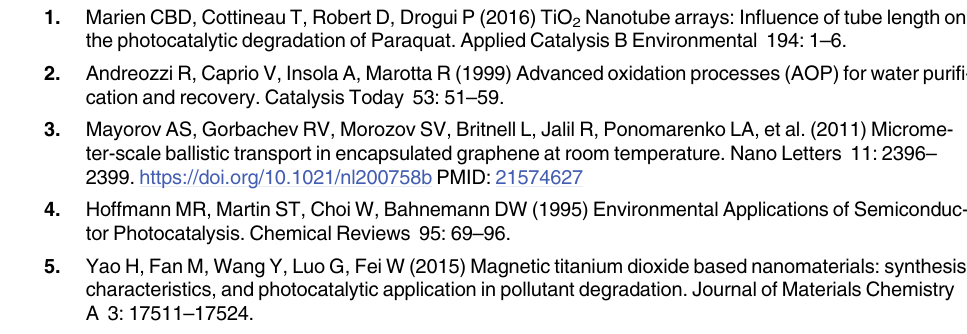
initial R6G concentration, 10 mg/L. Different small letters indicate significant difference (Duncan’s test, p < 0.05) among treatments (n = 3). S6 Fig. R6G declining curves of the synthesized magnetic-TiO -nanocomposites without 2 UV-irradiation. (A) pH = 3.0, (B) pH = 7.0, (C) pH = 10.0. Experimental conditions: initial magnetic-TiO2-nanocomposites concentration, 0.4 g/L; initial R6G concentration, 10 mg/L. Different small letters after each line indicate significant difference (Duncan’s test, p < 0.05) among treatments (n = 3). S7 Fig. Impacts of irradiation wavelength on the R6G photocatalytic degradation of the synthesized magnetic-TiO -nanocomposites. (A) 460 nm, (B) 540 nm. Different small letters 2 after each line indicate significant difference (Duncan’s test, p < 0.05) among treatments (n = 3). S8 Fig. Percentage of R6G loss during the photocatalysis process. The number in x-axis (0.2, 0.4 and 0.8) indicates the concentration of the synthesized magnetic-TiO -nanocompo- 2 sites (mg/L), A refers to Fe O /TiO -0.5, B refers to Fe O /TiO -0.35, C refers to Fe O @TiO - x y 2 x y 2 x y 2 0.5, and D refers to Fe O @TiO -0.35, respectively. x y 2 S9 Fig. Effects of magnetic-TiO -nanocomposite concentration on R6G photodegradation 2 kinetics. (A) Fe O /TiO -0.5, (B) Fe O /TiO -0.35, (C) Fe O @TiO -0.5 and (D) Fe O @- x y 2 x y 2 x y 2 x y TiO -0.35. Different small letters after each line indicate significant difference (Duncan’s test, 2 p < 0.05) among treatments (n =